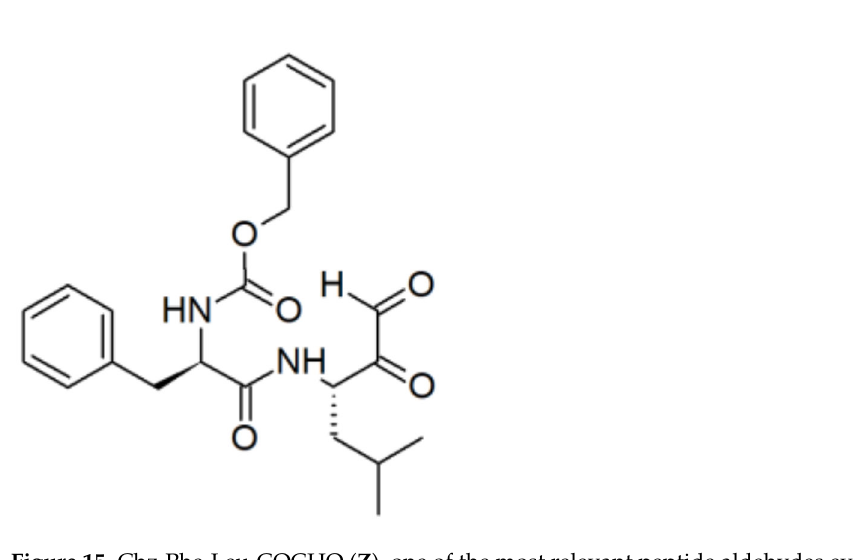
Figure 15. Cbz-Phe-Leu-COCHO ( Z ), one of the most relevant peptide aldehydes evaluated in the work by Walker et al., exhibiting CatS inhibition [128].